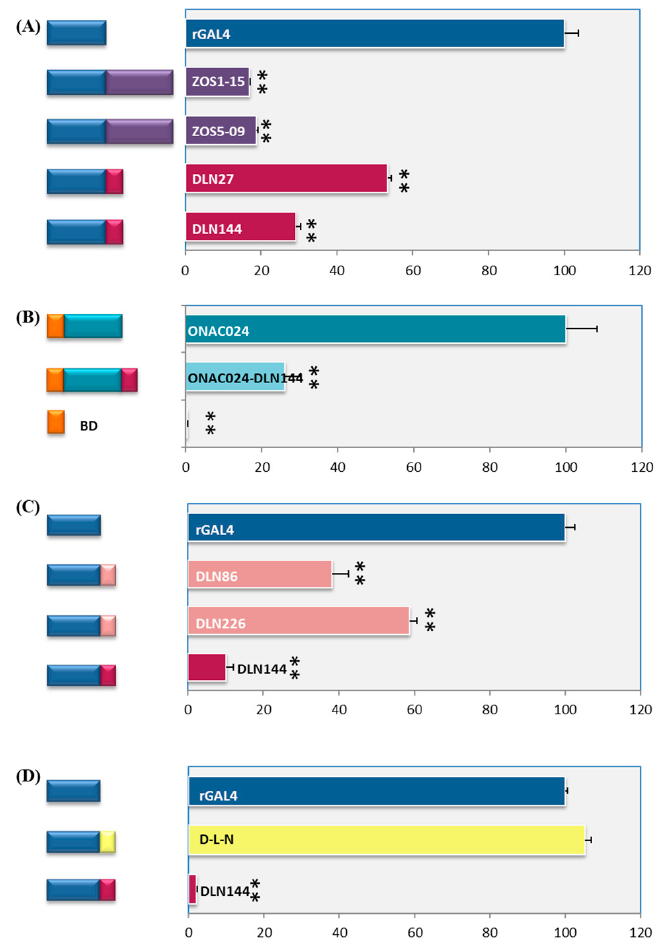
Figure 4. Repressive ability of the DLN motif. ONPG assay showing β -galactosidase units, with o-nitrophenyl- β - D -galactopyranoside as the substrate, on the x -axis for various fusion products as mentioned. ( A ) rGAL4 fused with complete ORFs (purple bars) of ZOS1-15, ZOS5-09 and their DLN motifs (red bars), DLN27 (DLNYPP), DLN144 (DLNSPP), respectively; ( B ) DLN144 fused with an activator, ONAC024; ( C ) DLN86 and DLN226a lacking P conservation in the hexapeptide, fused with rGAL4, and ( D ) the activity of tripeptide D-L-N motif in comparison with the hexapeptide DLN. The repression efficacy of all constructs has been depicted in terms of percentage in comparison to the transactivation ability of reconstituted GAL4 TF (rGAL4, in A , C and D ). In ( B ), DLN144 hexapeptide motif from ZOS5-09 represses activation by ONAC024, and the binding domain (BD from vector pGBKT7) is the negative control. The line diagrams on the left side are a representation of the fused protein, with blue and red colors denoting rGAL4 and DLN144 hexapeptide motif from ZOS5-09, respectively. The asterisks represent p -value ≤ 0.005, in biological triplicates. The standard error bars have been